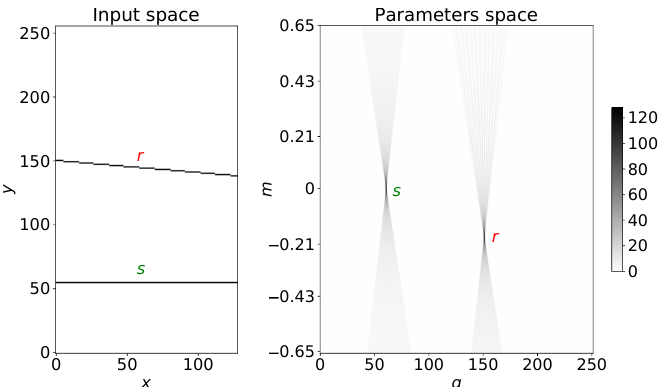
Figure 2. Example of the Hough transform of two straight lines with different slopes. In the left plot, the lines are drawn in the x - y input plane, while in the right plot their parameters are shown as being computed by the Hough transform: each line in the input space is translated into a family of straight lines intersecting in their relative parameter space